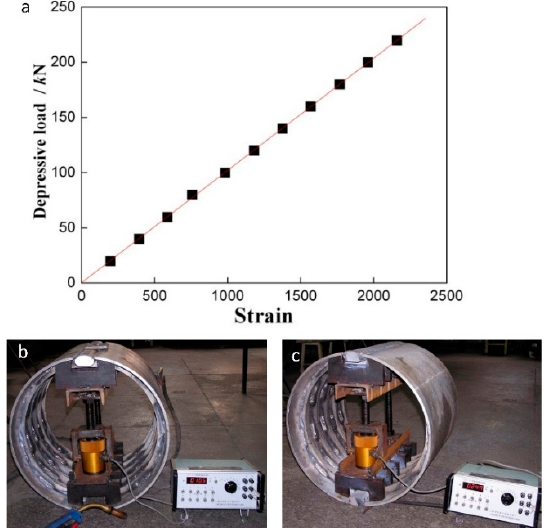
Figure 8. Depression load and strain measurement of strain before and after welding. ( a ) Relation of welding depression load and strain ( b ) Depression strain before reinforcing plate welding ( c ) Depression strain after reinforcing plate welding.